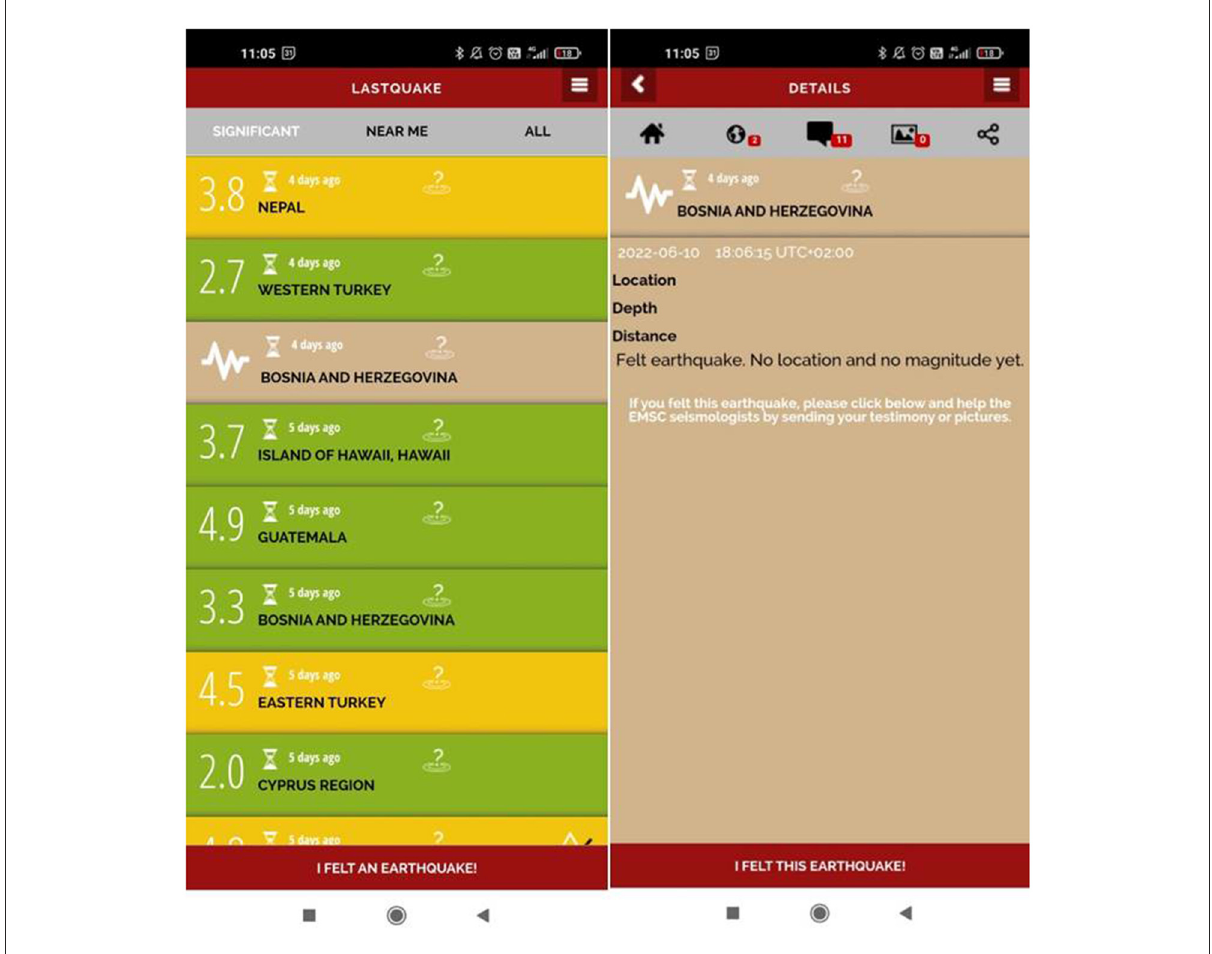
FIGURE3 Display of the new event type in the LastQuake